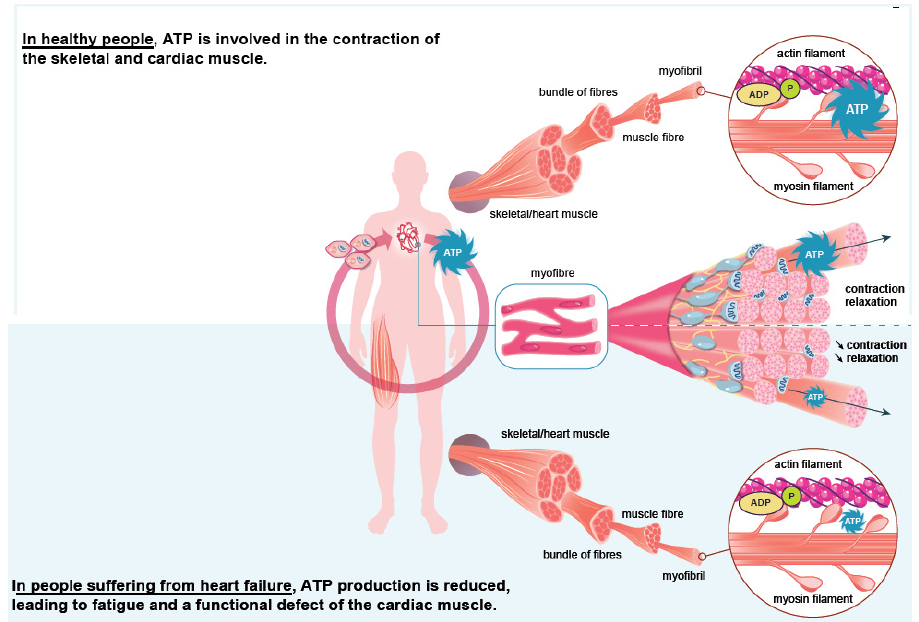
Figure 1. Role of iron in the heart muscle’s functioning. Iron is notably mandatory for the energy production involved in heart contractions and for the oxygenation of the muscle, which ensures its correct function over time.